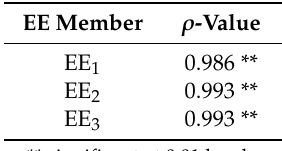
Table 15. Consistency test I (Intra-group: EE